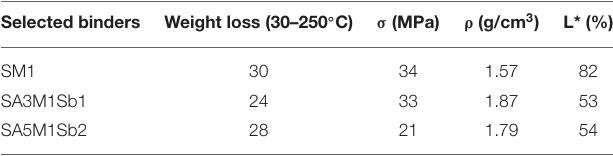
TABLE 2 | Weight loss resistance to compression and density of the selected binders and